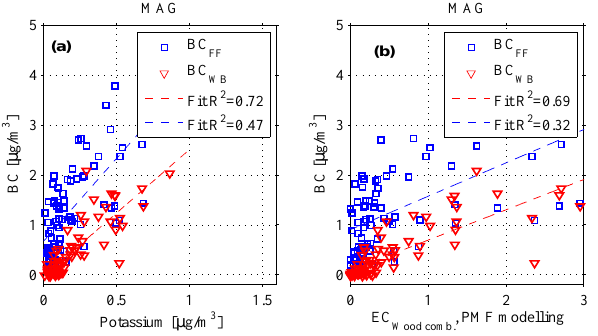
Fig. 6. Scatter plot of daily BC (BC FF and BC WB ) and potassium for MAG (a) . Scatter plot of daily BC (BC FF and BC WB ) and EC from wood combustion emissions as derived from PM 10 factor ana- lytical modelling for MAG (b) . Both plots include linear regression